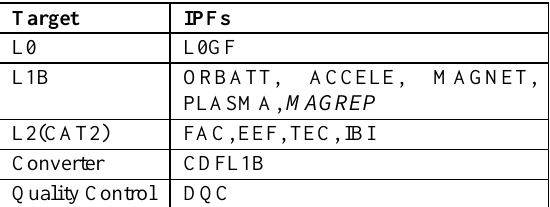
Table 2: Swarm Instrument Processing